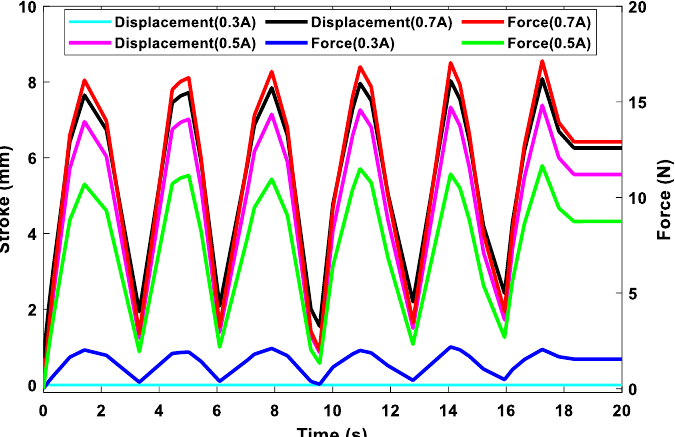
Figure 8. Force generated by the SMA spring and stroke required to open the thermostat.